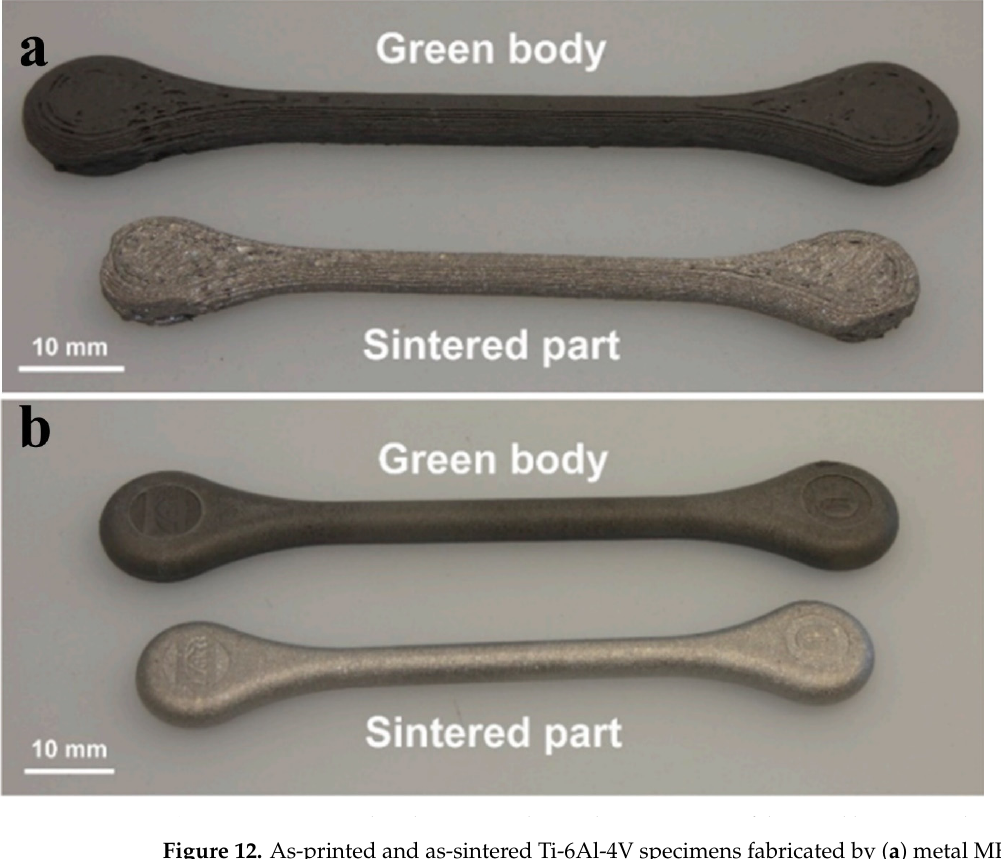
Figure 12. As-printed and as-sintered Ti-6Al-4V specimens fabricated by ( a ) metal MEX process and ( b ) MIM process, demonstrating the difference in sizes due to shrinkage upon sintering (adapted from [91]).